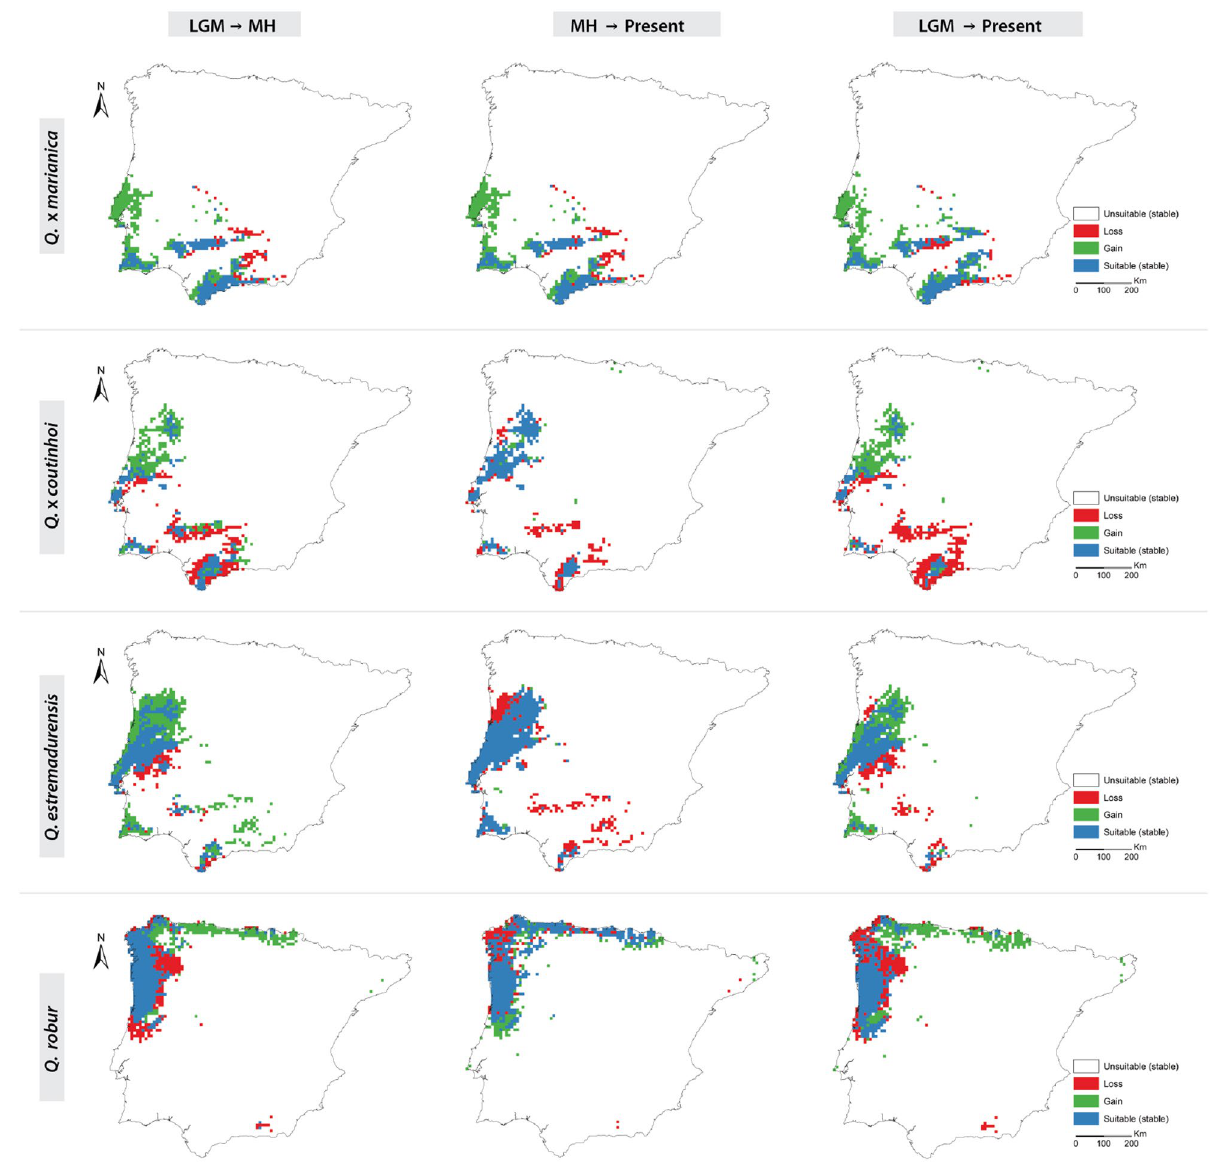
Figure 2. Changes in the predicted distributions (gained, lost, or stable) of hybrids ( Q x marianica and Q. × coutinhoi ) and Roburoid oaks ( Q. estremadurensis and Q. robur ) for the studied periods: LGM-MH (left); MH-Present (center); LGM-Present (right). Maps were generated by JG and CVV in R v.4.0.3 (https ://www.r- proje ct.org) and assembled in ArcMap 10.5 (https ://www.esri.com/en-us/arcgi